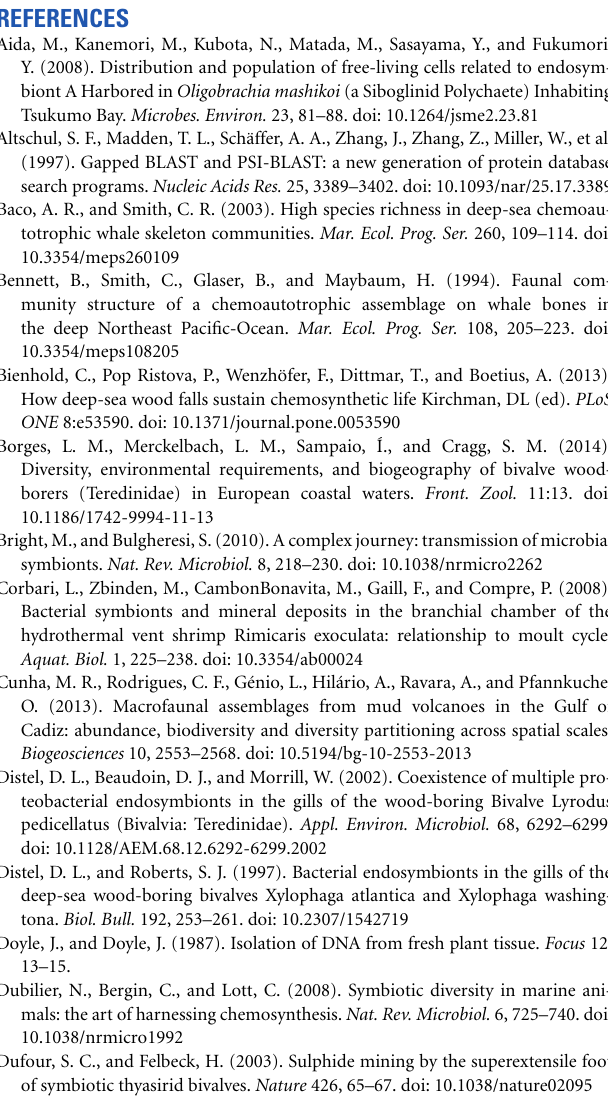
Table S3 | The total number of V5-V6 sequences at OTU identity threshold of 97% in the most abundant OTUs, represented by more than 1% of the total number of sequences in the dataset ( > 3000 amplicons). OTUs were assigned to different bacterial phylotypes by Blast on SILVA 115 database with OTU identity threshold at 97%. The relative percentage was normalized by the total number of the most abundant bacterial sequences per site. Refer to Table 1 for sample ID. Table S4 | Estimation of the influence of each variable and factor and their respective significance in redundancy analysis (RDA), assessed using ANOVA permutation tests in R (R Development Core Team, 2013). Sample IDs are described in Table 1 . Table S5 | The total number of sequences of symbiont-related OTUs identified by the “symbio” key word in at least one of their four best BLAST hit definitions or high similarity with a sequence from the symbiont database and confirmed by the phylogenetic proximity. Only OTUs displaying a symbiont sequence as their closest relative on the phylogenetic tree were retained. Sample IDs are described in Table 1